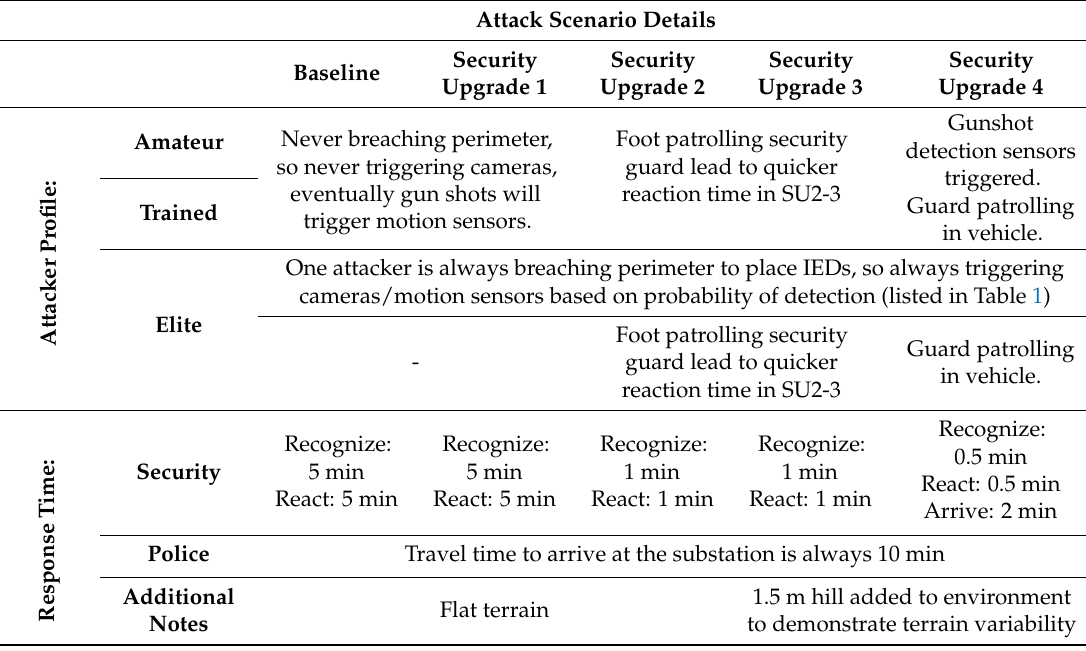
Table 3. Attack Scenario